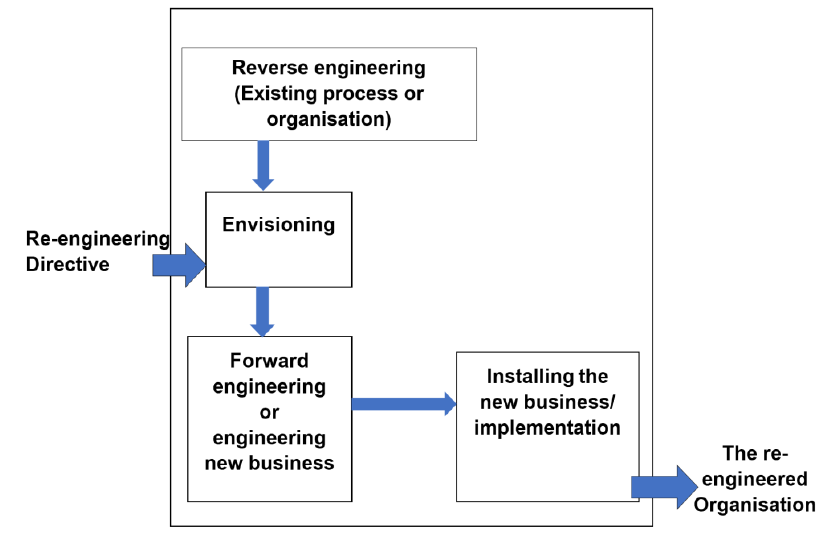
Figure 4. Jacobson ’s BPR methodology. Figure 4. Jacobson’s BPR